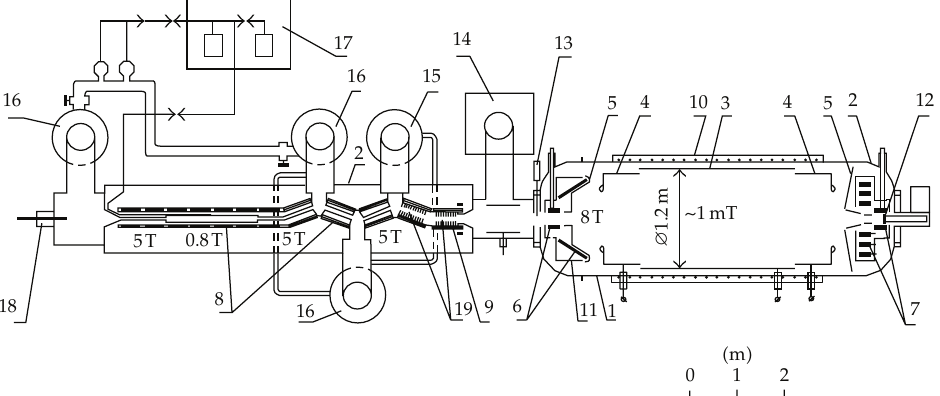
Figure12:TheTroitskNeutrinoMassExperiment:vacuumvesselofMAC-E-Filter (1) andofwindowlessgaseoustritiumsource (2) ,retarding electrodes (3,4) , ground electrode (5) , superconducting solenoids (6–9), warm solenoid (10) , LN 2 shield (11) , Si(Li) detector (12) , emergency valve (13) , magnetodischarge pump (14) , mercury diffusion pumps (15-16) tritium purification system (17) , electron gun (18) , and argon trap (19) . (Reprinted with permission from [67], Copyright (2011) by the American Physical Society).